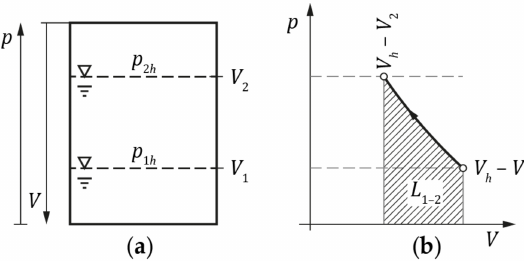
Figure 7. ( a ) Liquid volumes and gas pressures in the hydrophore before and after filling the hydrophore. ( b ) Air pressure in the hydrophore, where V 1 is the initial volume of the liquid, V 2 is the final volume of the liquid, V h is the total volume of the hydrophore, p 1 h is the initial gas pressure, p 2 h is the final gas pressure and L 1 − 2 is the work performed during gas compression (hatched